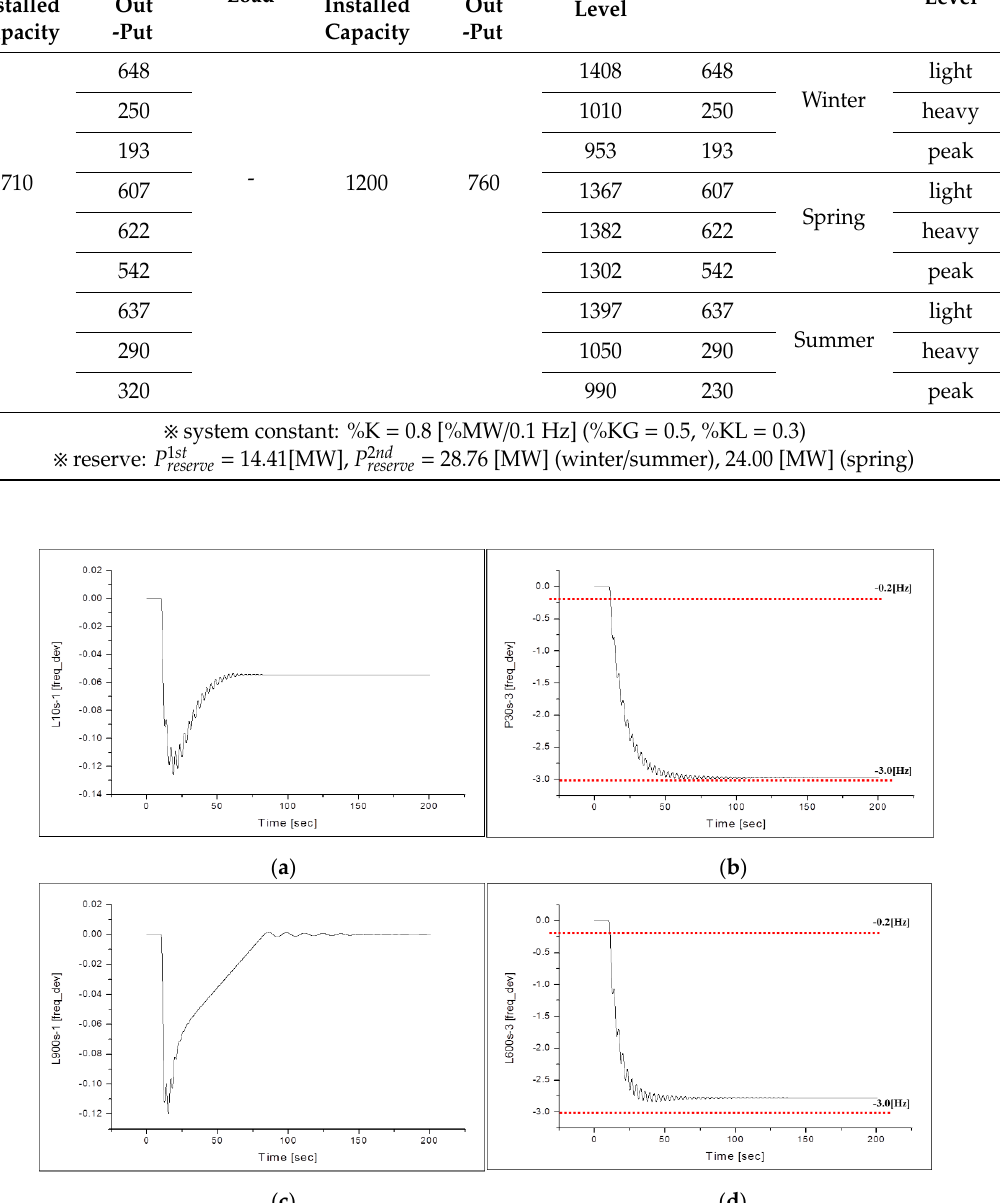
Table 7. Simulation data of the P steel company.